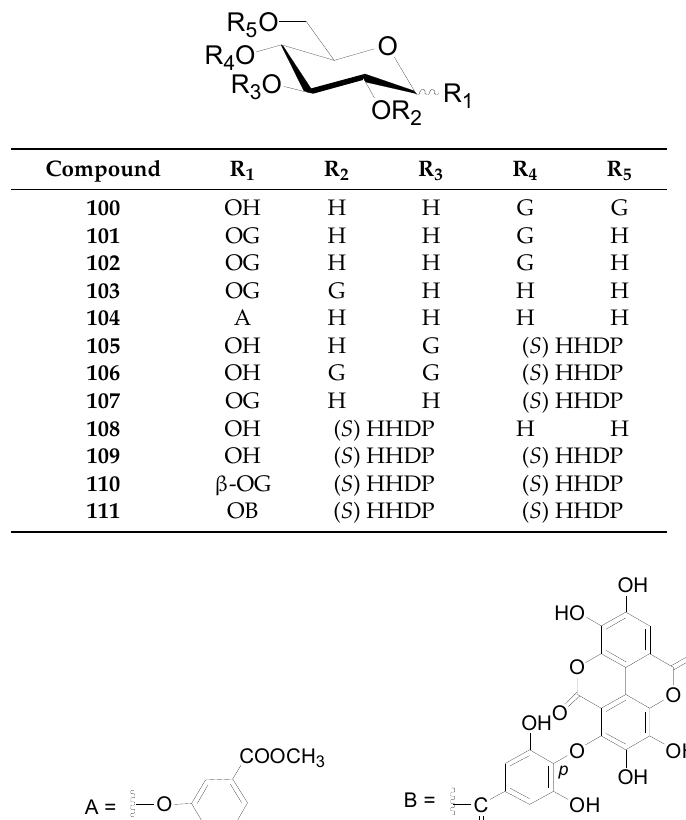
Table 4. Structures of compounds 100 – 111 .